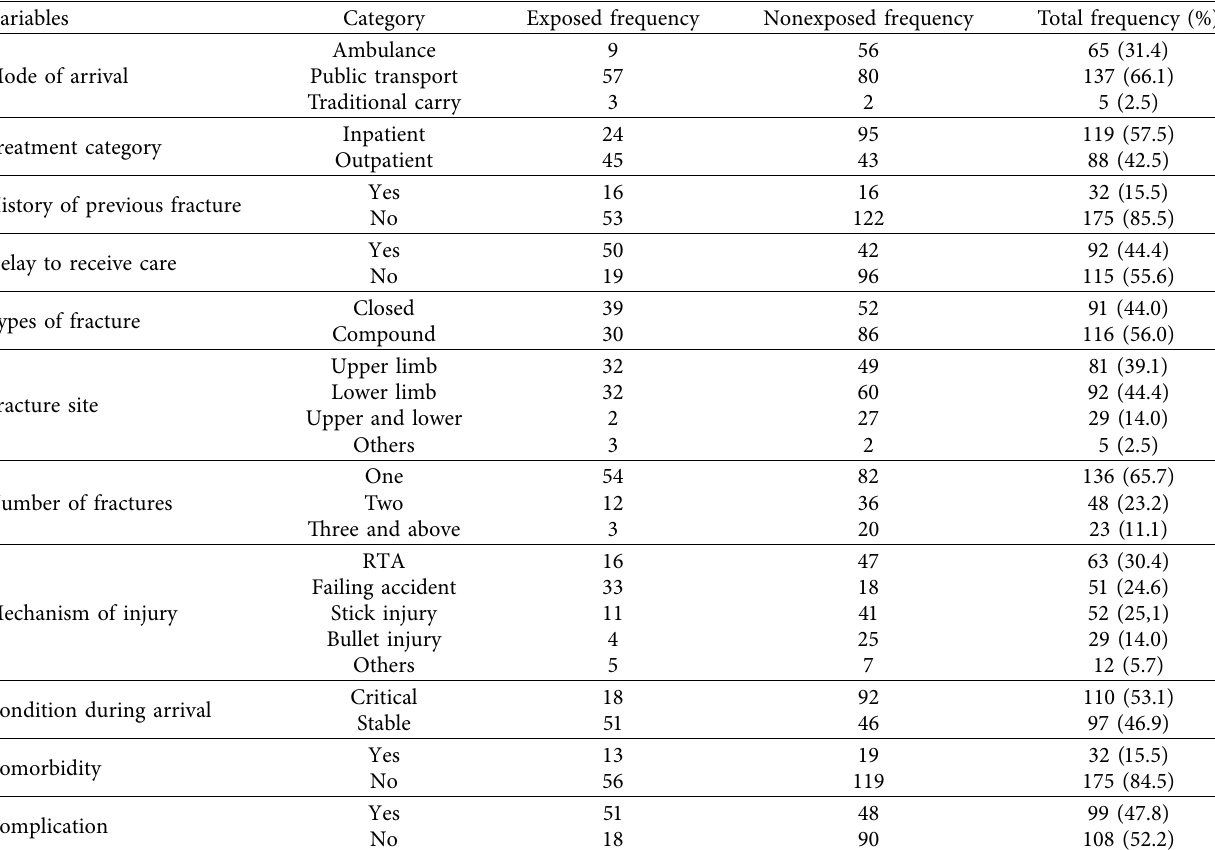
Table 2: Clinical characteristics of patients with fracture in DMCSH,